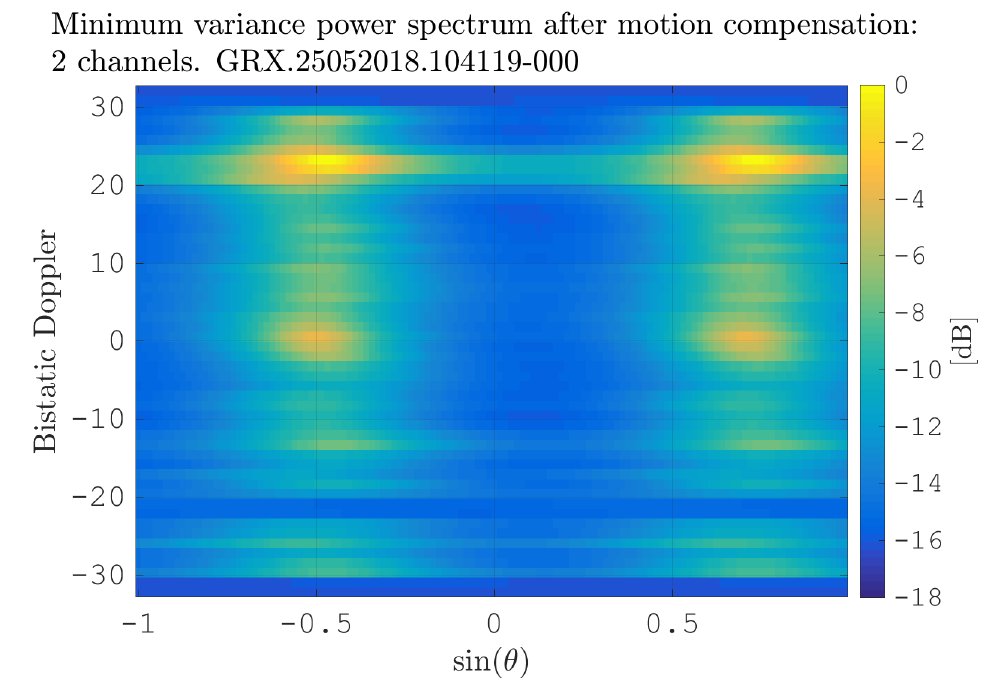
Figure 11. Minimum variance power spectrum after flex-DPCA application, i.e., after applying